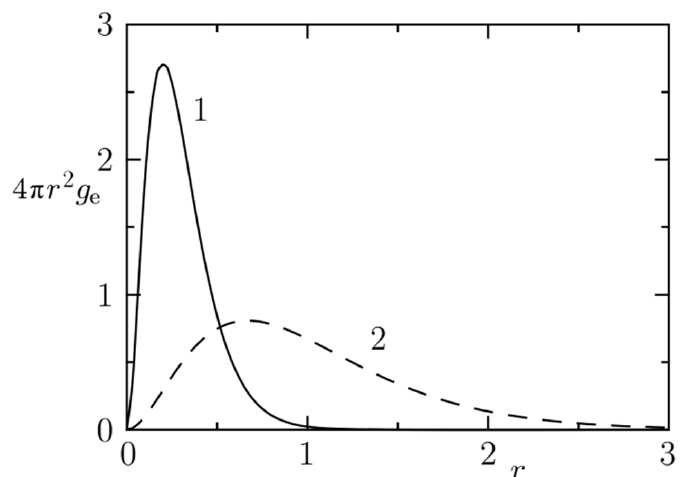
Figure 3. Spatial density g ( r ) of the exponentially smeared charge for two decay constants λ = 0.20 (1) and λ = 0.67 (2). Reproduced from Phys. Chem. Chem. Phys. 2016 , 18 , 16127 https://pubs.rsc.org/en/content/articlelanding/2016/cp/c6cp00341a, accessed on 15 December 2021 (supporting information) with permission from the PCCP Owner Societies.